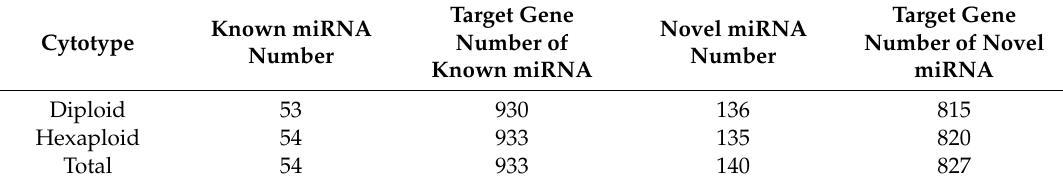
Table 2. The number of miRNAs and target genes in two cytotypes of S. canadensis